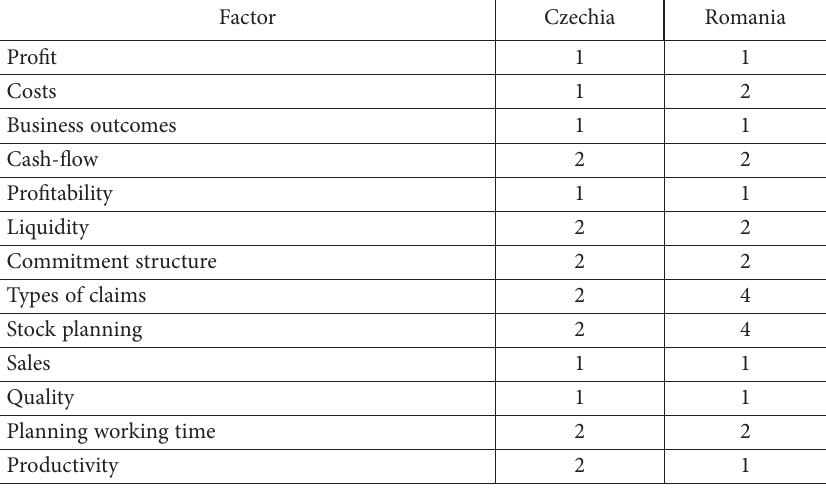
Table 3. Financial issues – importance (source: survey data, compromise solution values, differences are in bold) Factor Profit 1 1 Costs